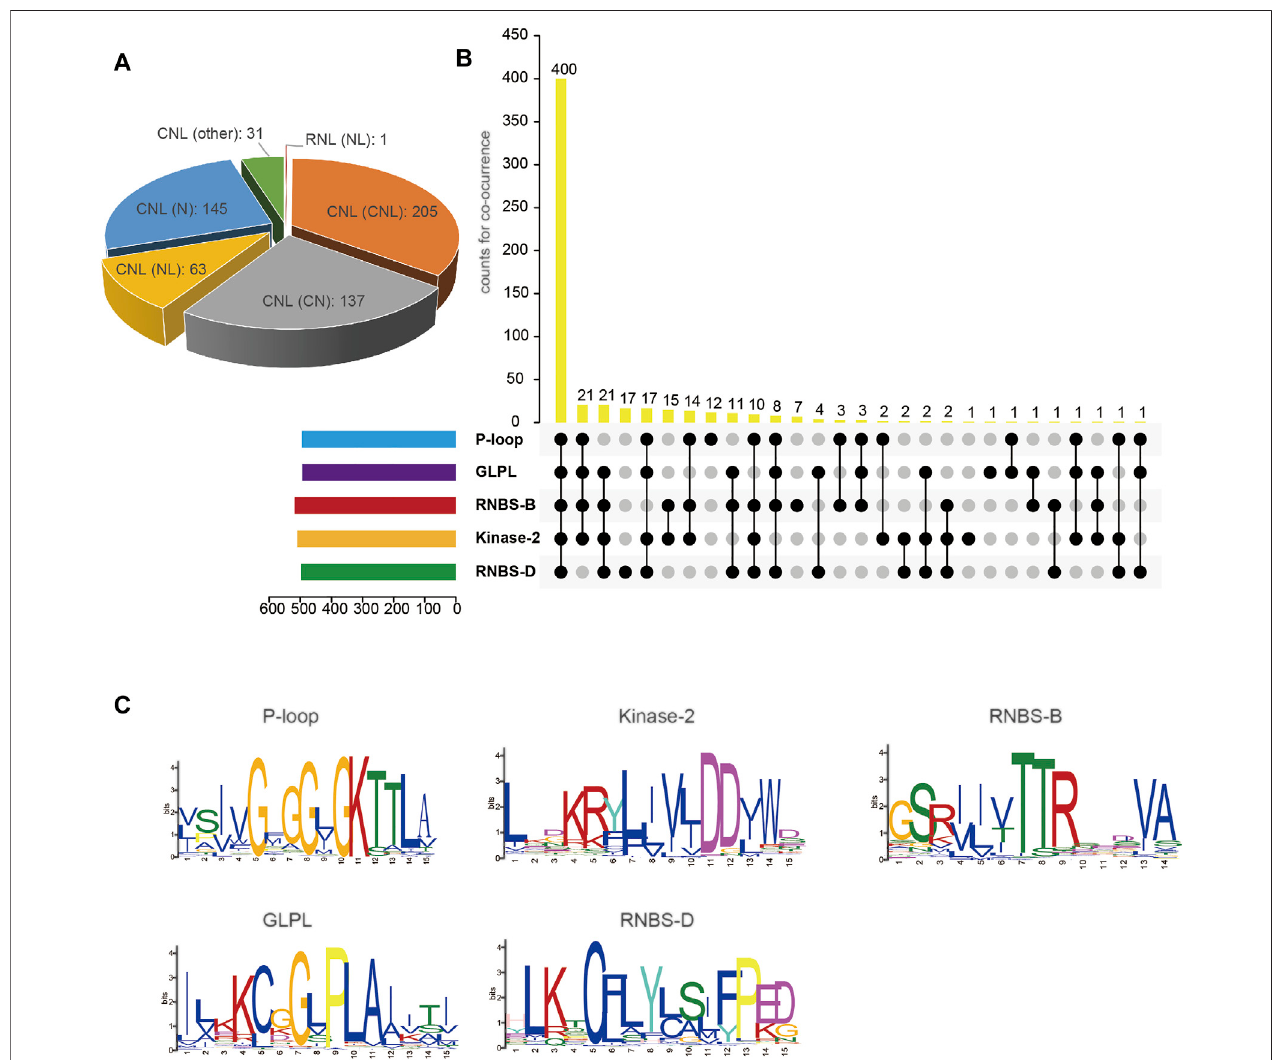
FIGURE1| Classi fi cationandsequencefeaturesofNBS-LRRgenesin S.cereale . (A) Classi fi cationanddomaincompositionsof S.cereale NBS-LRRproteins. (B) Presence of fi ve key motifs in the amino acid sequence of the NBS domain of S. cereale NBS-LRR protein. (C) Amino acid features of fi ve key motifs in the amino acid sequence of the NBS domain of S. cereale NBS-LRR